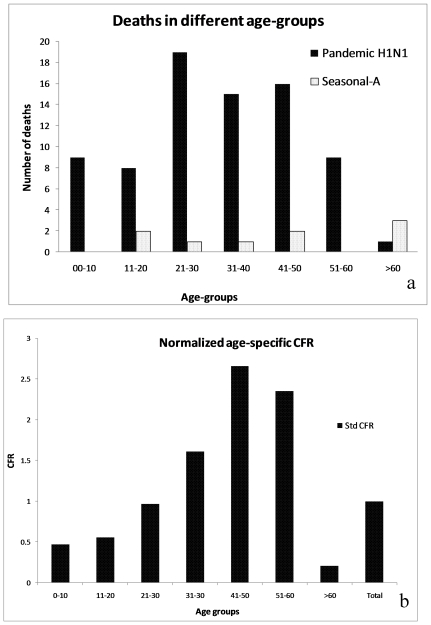
(a) Age-wise distribution of death cases in Pune (b) The normalized age specific CFR.